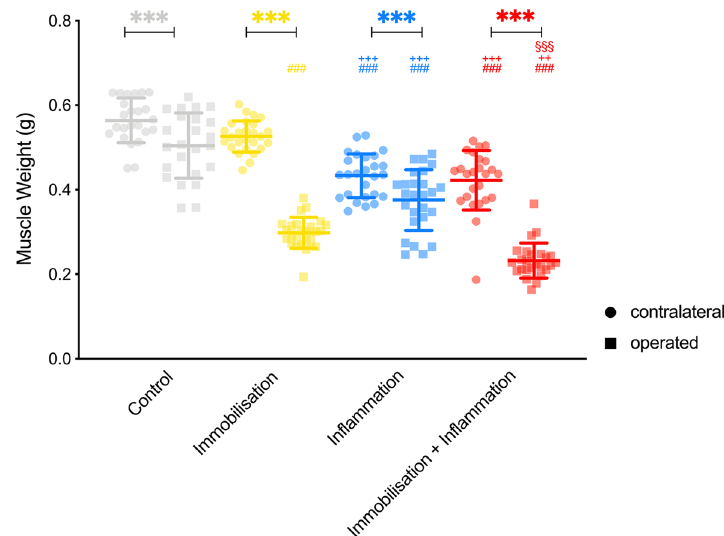
Fig. 4 Muscle weight in gram. In all 4 groups a significant difference in muscle weight between the operated and contralateral leg was present ( p < 0.001 for all four groups). The control group (mean [SD]; contralateral: 0.56 [0.05]; operated: 0.50 [0.08]) had significantly higher muscle weights in the contralateral and operated leg in comparison with the inflammation (mean [SD]; contralateral: 0.43 [0.05]; p < 0.001; operated: 0.38 [0.07]; p < 0.001) as well as immobilisation and inflammation group (mean [SD]; contralateral: 0.42 [0.07]; p < 0.001; operated: 0.23 [0.04]; p < 0.001). Meanwhile, only in the operated leg a significant difference between the control and immobilisation group (mean [SD]; operated: 0.30 [0.04]; p < 0.001) was present. The immobilisation group showed a significantly higher muscle weight in the contralateral leg (mean [SD]; contralateral: 0.53 [0.04]) in comparison with the inflammation ( p < 0.001) as well as immobilisation and inflammation group ( p < 0.001) while showing a lower muscle weight in the operated leg in